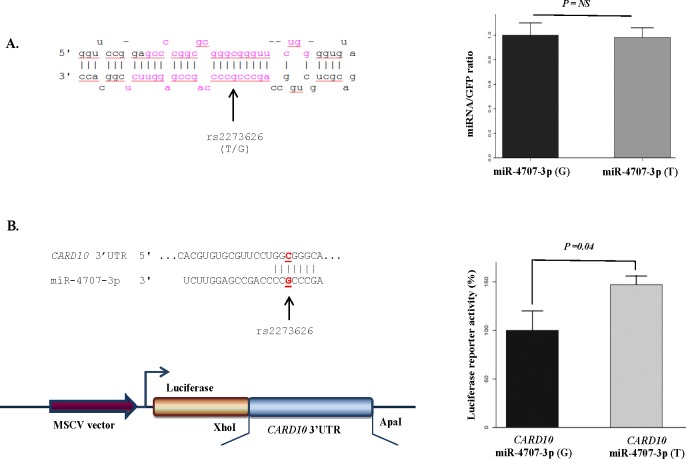
The impact of SNP rs2273626 in the seed sequence of miR-4707 on miRNA production and targeting. (A) The figure shows the predicted hairpin structure of miR-4707 containing rs2273626, which was associated with VCDR and cup area. The mature miRNA sequences (3p and 5p) are shown in red and the position of variants is depicted by an arrow. To examine the effect of rs2273626 on the miR-4707 expression level, HEK293 cells were transfected with GFP-miRNA transcripts containing either the minor allele T or the major allele G. The levels of mature miRNA relative to GFP transcript levels were calculated. (B) Luciferase reporter assays indicating miR-4707-3p–mediated repression of CARD10. HEK293 cells were cotransfected with CARD10 3′UTR luciferase reporter vector and GFP-miRNA transcripts containing either the minor allele T or the major allele G. This experiment indicates a significant difference (P = 0.04) between the relative luciferase activity of the CARD10 3′UTR construct in the presence of miR-4707-3p containing the major allele and the minor allele. Our results suggest that rs2273626 diminishes the regulatory interaction between miR-4707-3p and CARD10, resulting in increased CARD10 levels. All experiments were performed in triplicates and repeated at least three times. Error bars represent standard deviation (SD). NS, nonsignificant.